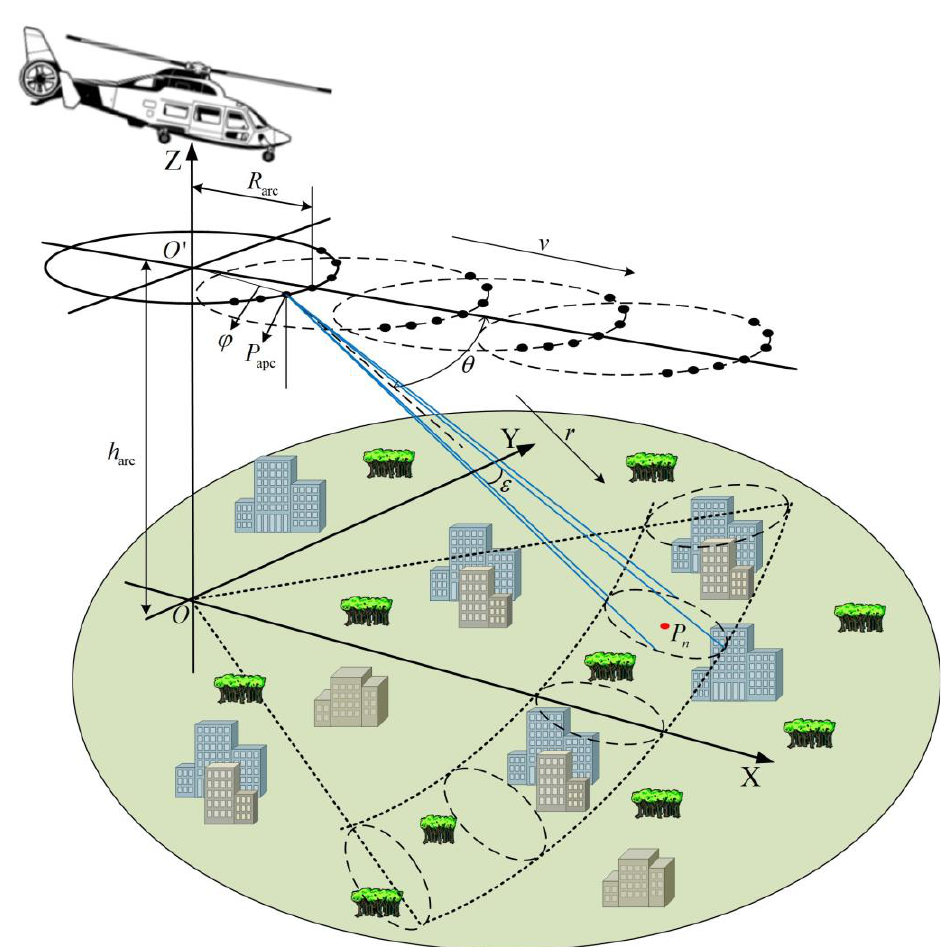
Figure 2. AASAR observation scene model in forward